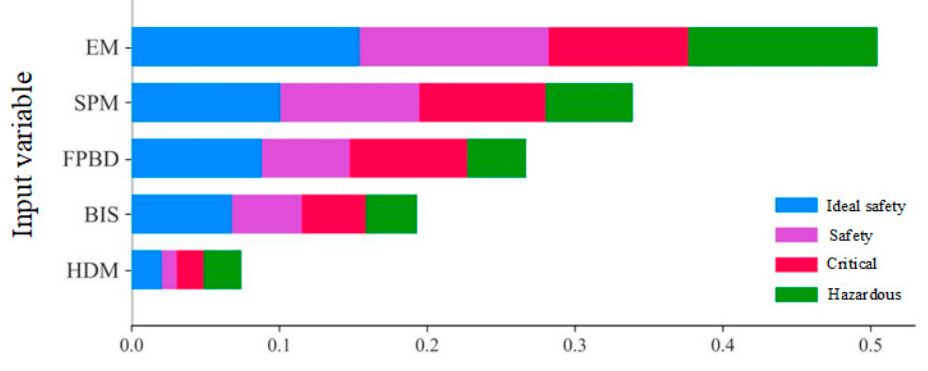
Figure 3. Confusion matrix of an RF classifier model for the fire risk database of stadium: ( a ) training set and ( b ) test set (IS: Ideal Safety, S: Safety, C: Critical, and H: Hazardous).